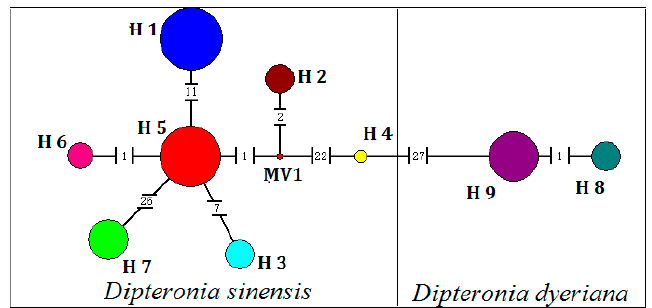
Figure 2. TCS-derived network of genealogical relationships between the nine haplotypes found in Dipteronia Oliv. Missing haplotypes are represented by hatch marks. The sizes of circles are approximately proportional to sample size.